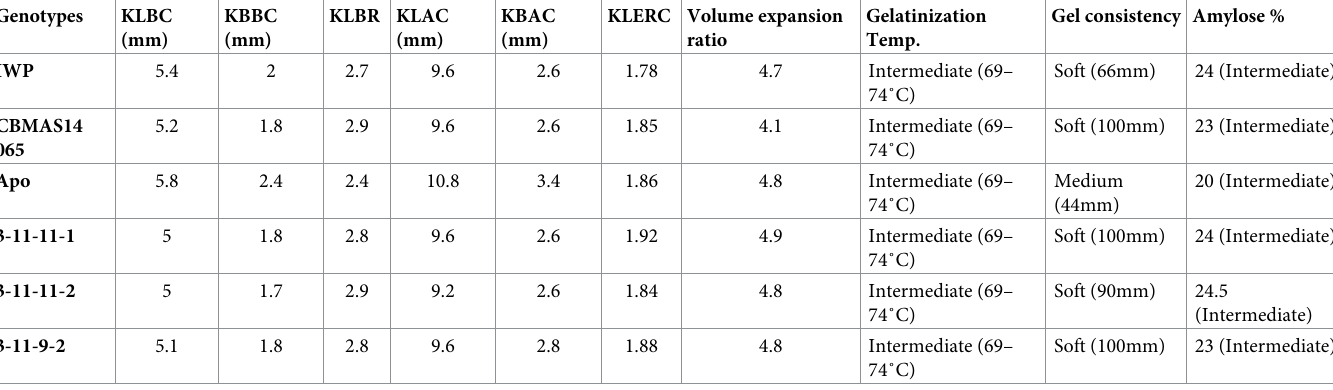
Table 9. Grain and cooking quality traits of BILs.